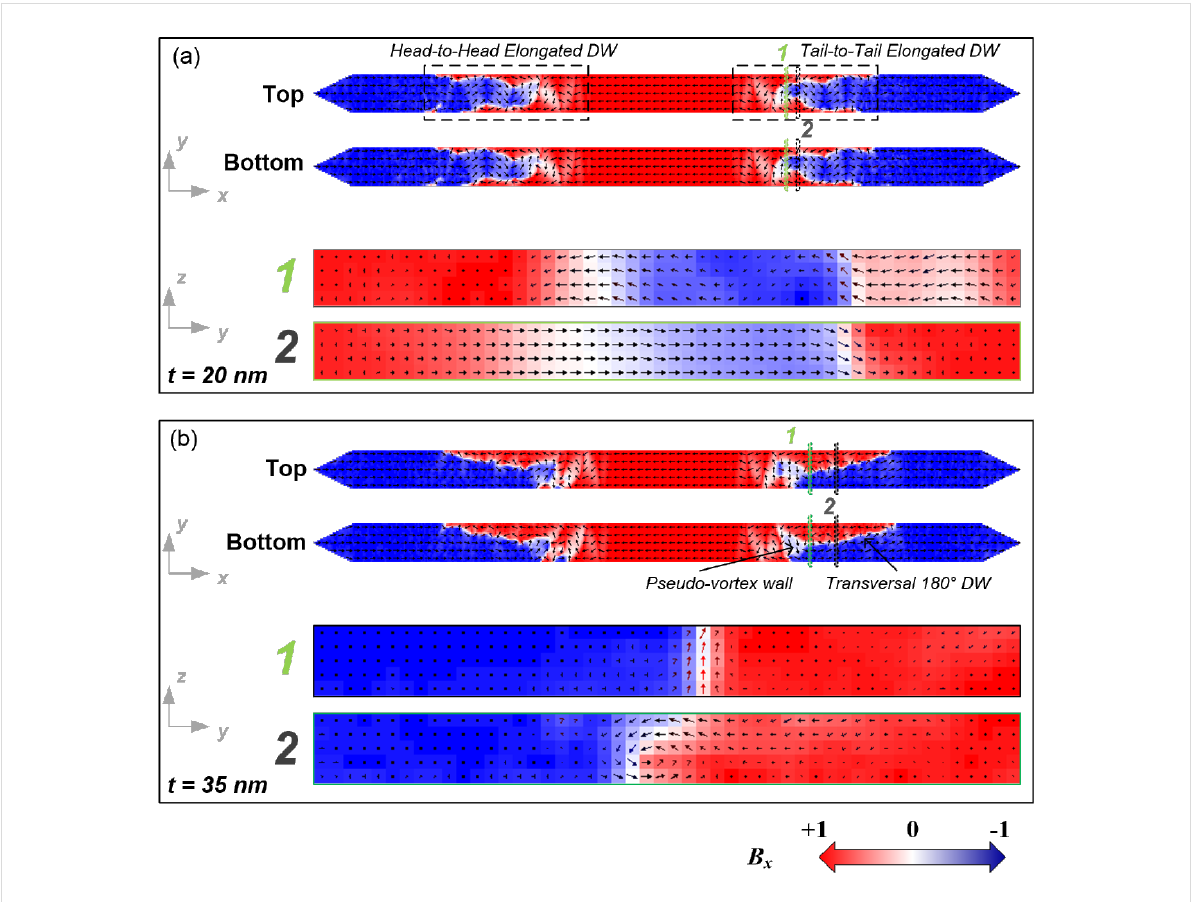
Figure 8: Magnetization vector-color maps extracted from the simulations for 250 nm wide Fe nanowires with rectangular profile (case I) and thick- ness of (a) 20 nm and (b) 35 nm. The areas named “1” (green lines) and “2” (black lines) in the x , y plane representations have been chosen for the representation in the y , z